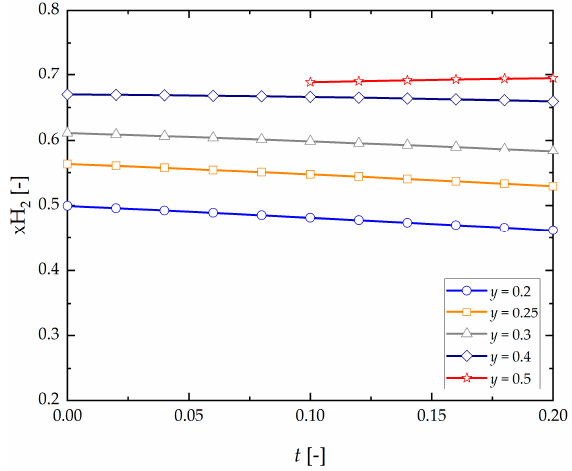
= 𝑓(𝑡,𝑦) with y = const, of the reforming process = f ( t , y ) with y = const, of the reforming process = 𝑓(𝑡, 𝑦) with y = const, of the reforming process (cid:3118) 2 (cid:3118)